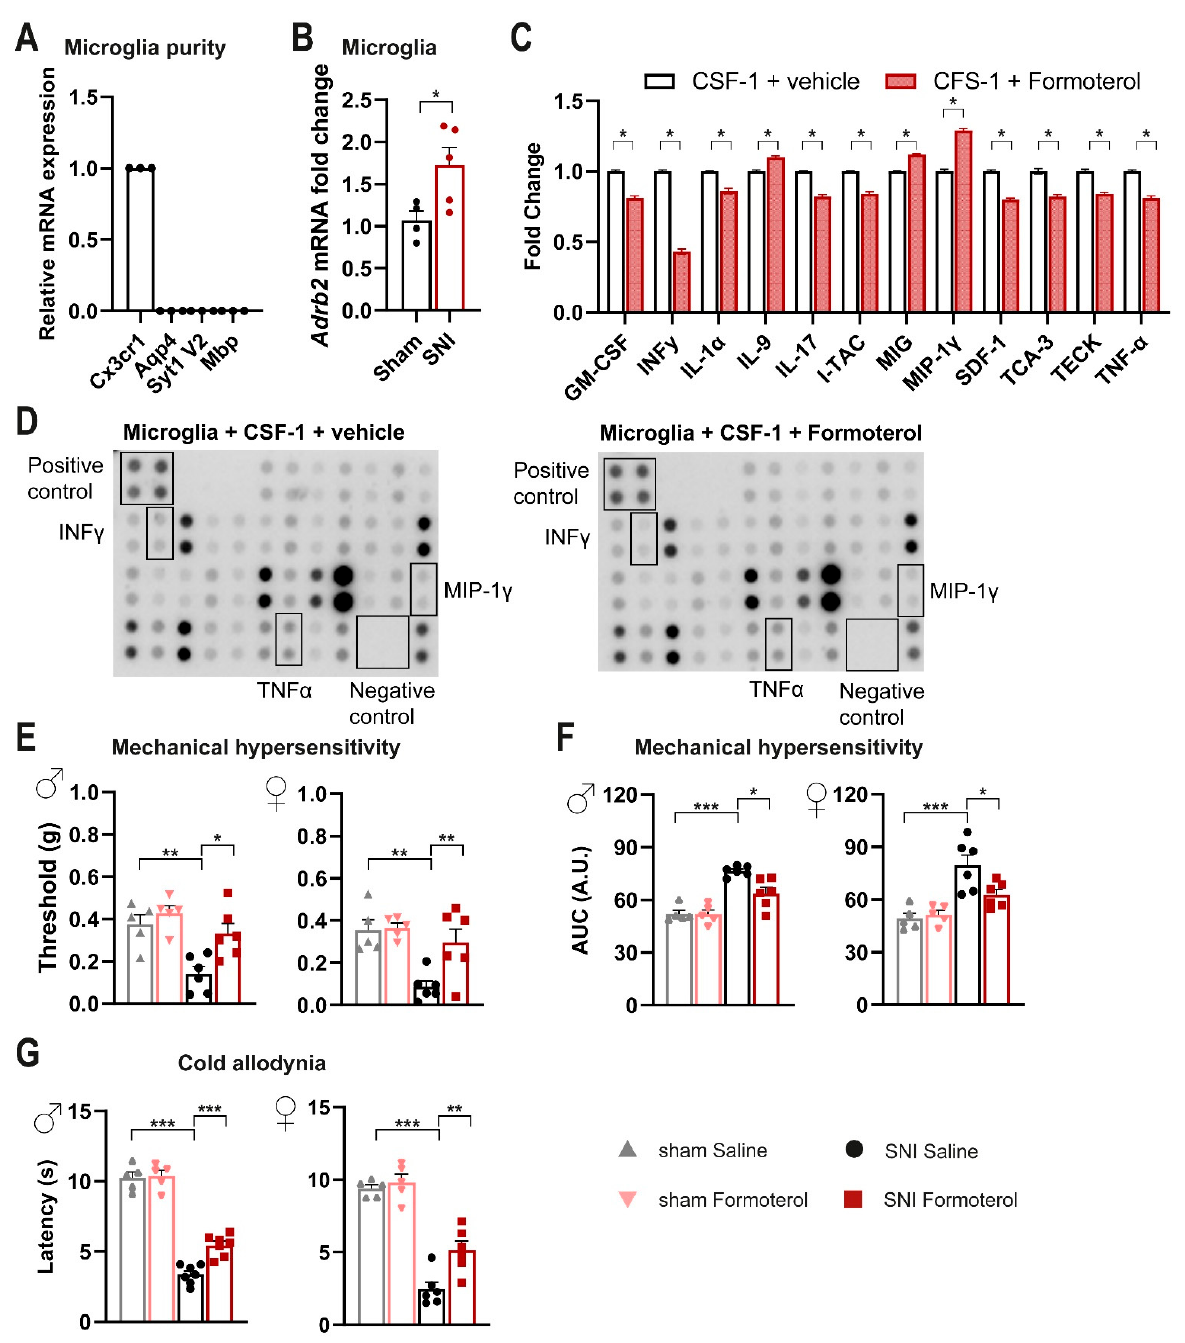
Figure 1. Spared nerve injury-induced induces upregulation of the Adrb2 mRNA in microglia, whereas β 2-AR agonist decreases inflammation markers in activated primary microglia cell culture and sensitization in vivo. ( A ) Purity check of microglia isolated from the spinal dorsal horn via qPCR on markers specific for microglia ( Cx3cr1 ), astrocytes ( Aqp4 ), neurons ( Syt1 V2 ), and oligodendrocytes ( Mbp ). n = 3. ( B ) Relative expression of Adrb2 mRNA in microglia isolated from the spinal dorsal horn of SNI- and sham-operated mice three days after surgery. n = 4–5/group; two-tailed unpaired t -test was performed; * p < 0.05 as compared between two groups. ( C ) Activated cultured microglia decrease the release of inflammatory mediators after Formoterol treatment. n = 4; two-tailed unpaired t -test was performed; * p < 0.05 as compared between two groups. ( D )